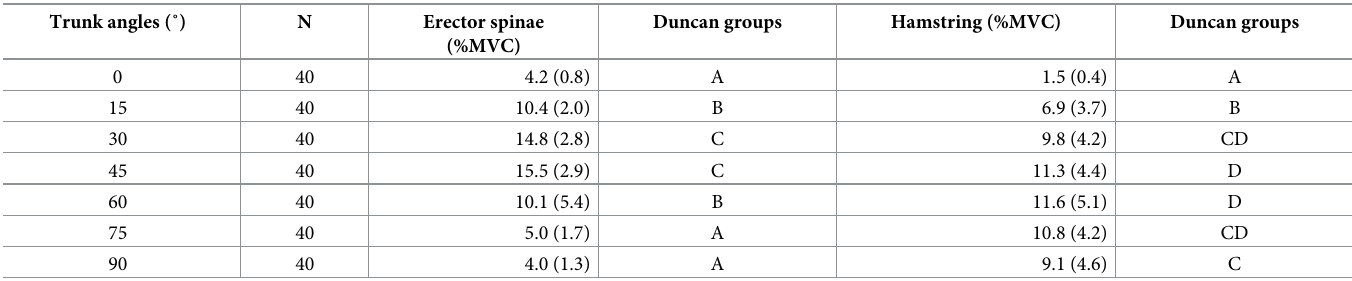
Table 3. Muscle activation of Duncan groups for varying trunk angles. Trunk angles (˚)